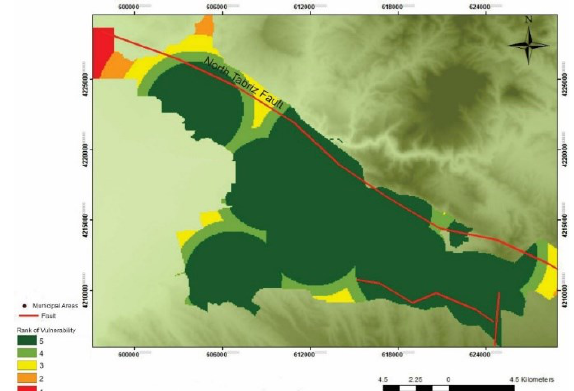
Fig. 8. Vulnerability map of Tabriz city based on population density layer